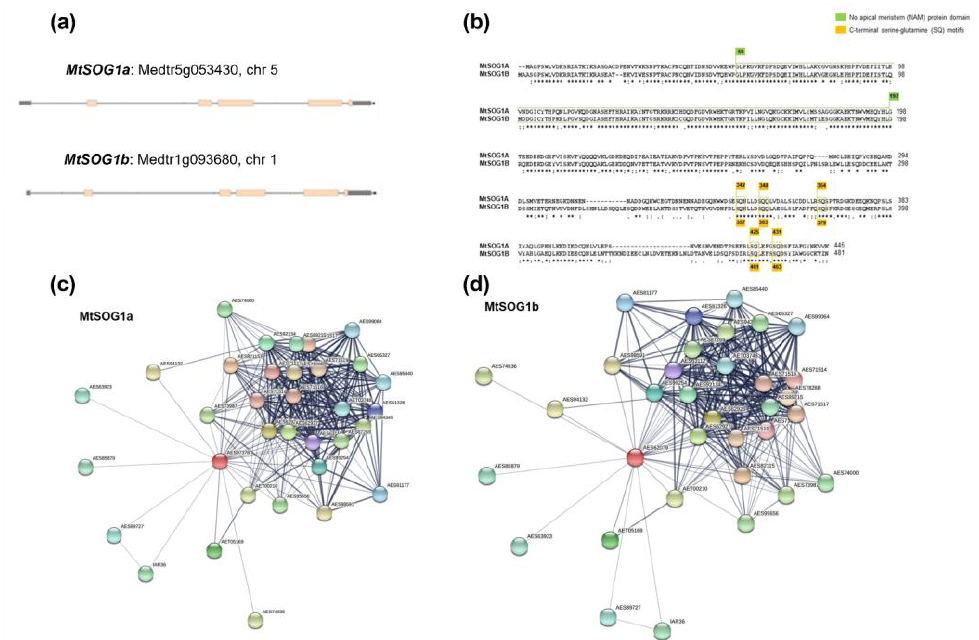
Figure 5. ( a ) Schematic representation of MtSOG1a and MtSOG1b gene organization as evidenced in the Phytozome (https://phytozome.jgi.doe.gov/, accessed on 19 March 2022) genome browser. Exons are presented as orange boxes. ( b ) Alignment of MtSOG1a and MtSOG1b protein sequences performed using ClustalW. The presence of NAM (No Apical Meristem) and SQ (Serine, Glutamine) motifs is evidenced in green and orange boxes, respectively. Putative protein – protein interaction networks generated by STRING for ( c ) MtSOG1a and ( d ) MtSOG1b proteins. Overall, the retrieved data indicate that many of the predicted SOG1 interactors can be found across species, and a large majority have ascertained functions in DDR and DDR- downstream pathways (e.g., DNA repair, cell-cycle checkpoint). It is also important to note that the interactomes of different SOG1 genes in the same species are largely over- lapping and to underline that many high-score interactors recur in all the retrieved in- teractomes, indicating the reliability of STRING analysis for literature data mining. 3.4. MtSOG1a and MtSOG1b Genes Are Upregulated during Seed Imbibition, Priming, and Genotoxic Stress Treatments